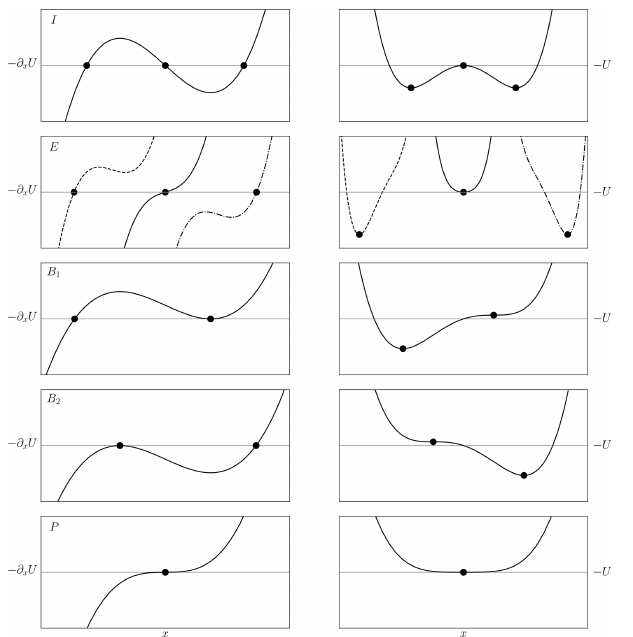
Figure 2. Sample potentials (right) and their derivatives (left) for (top to bottom) the three possible varieties of bimodal state ( I ), three types of unimodal state ( E ), the two pathological cases where D = 0 ( B 1 and B 2 ), and the cusp catastrophe point ( P ). Dots indi- cate the critical points. Scaling is not uniform between panels. Note the choice of negative sign of the potential U